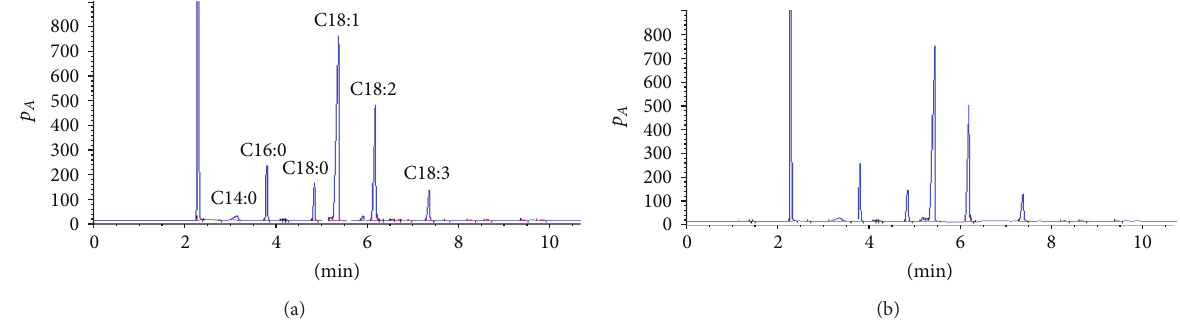
Figure 4: Chromatograms obtained from (a) Commercial oil, (b) FSC oil extracted to 45 ∘ C and 400 bar. Table 6: Antioxidant capacity of oils measured by the DPPH method (EC 100 bar 200 bar 300 bar Commercial